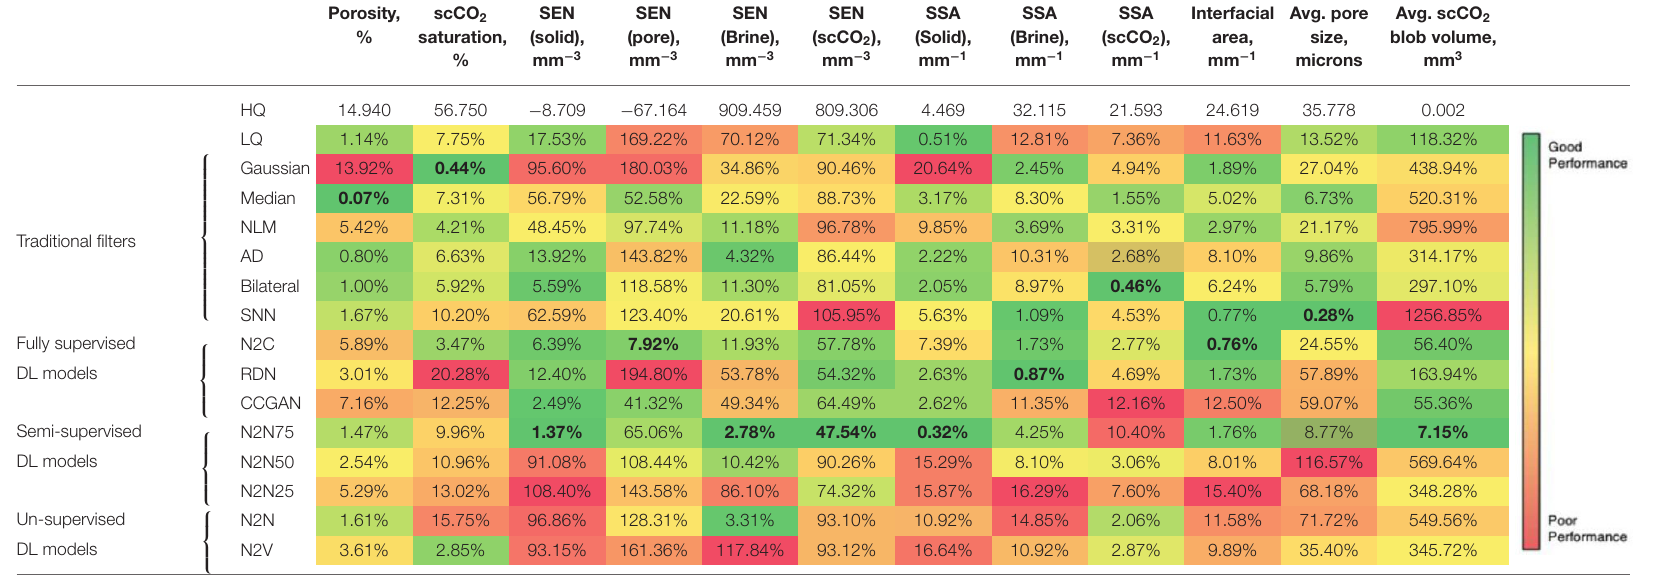
Porosity, scCO 2 %